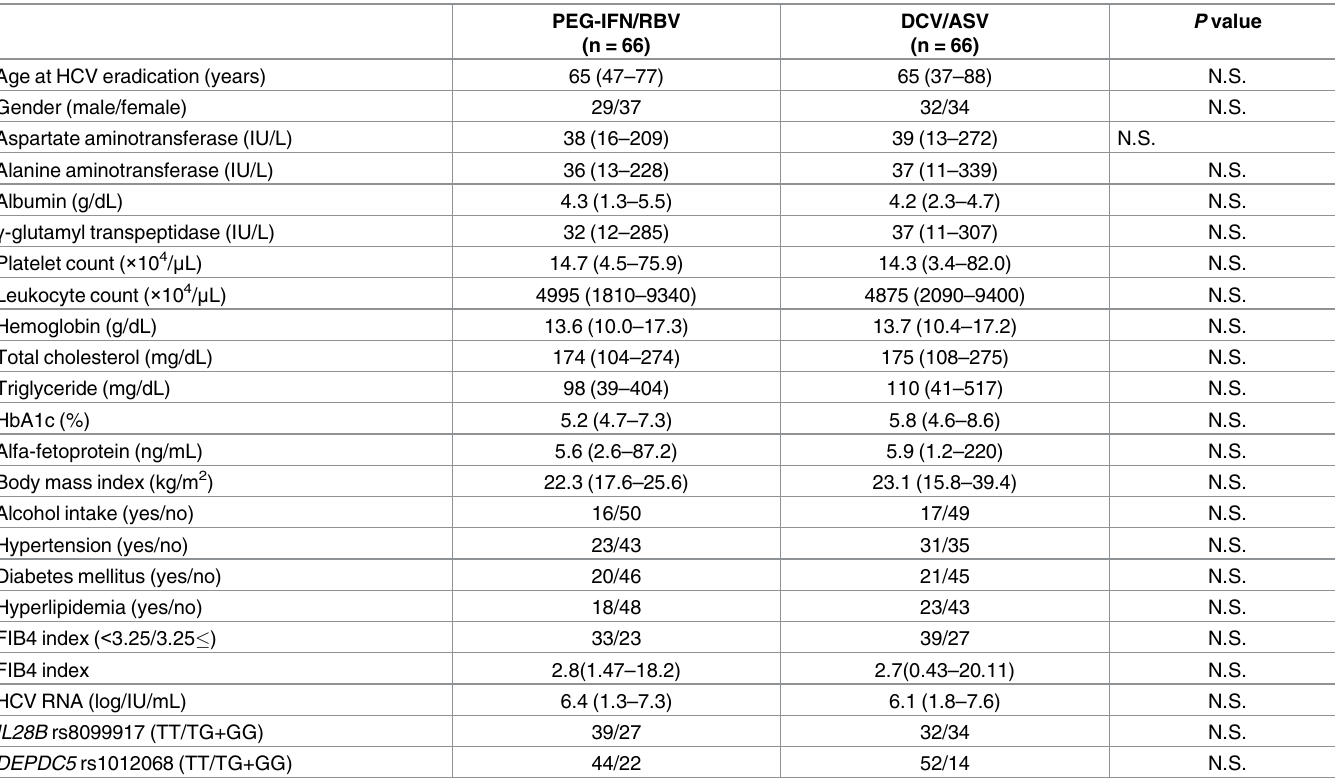
Table 2. Characteristics of propensity score-matched patient treated with PEG-IFN plus RBV or daclatasvir plus